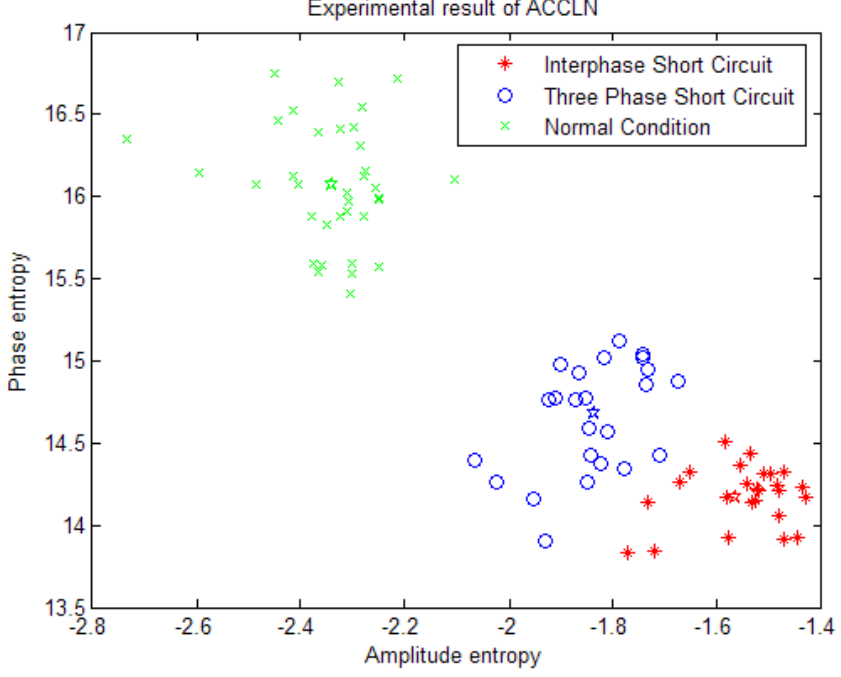
Figure 13. Experimental result of ACCLN (84 samples). X axis indicates amplitude entropy; Y axis indicates phase